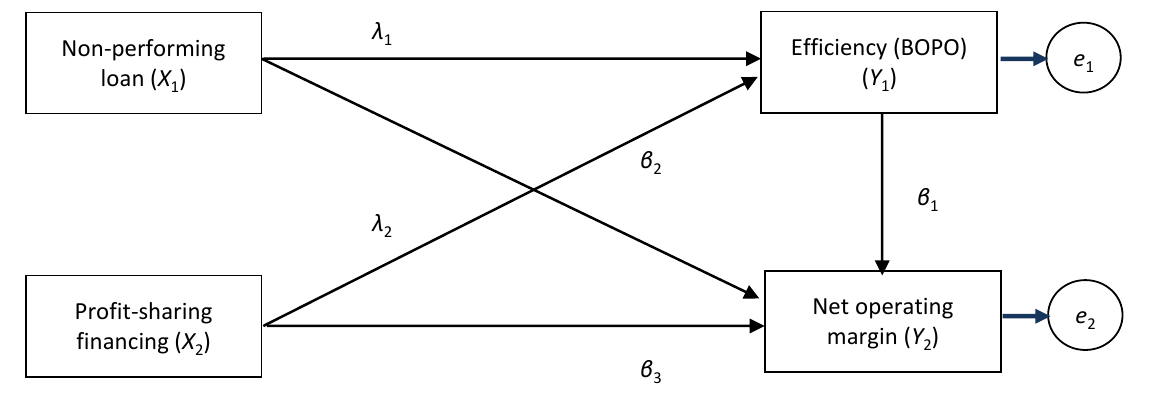
Figure 1. Proposed full path model for